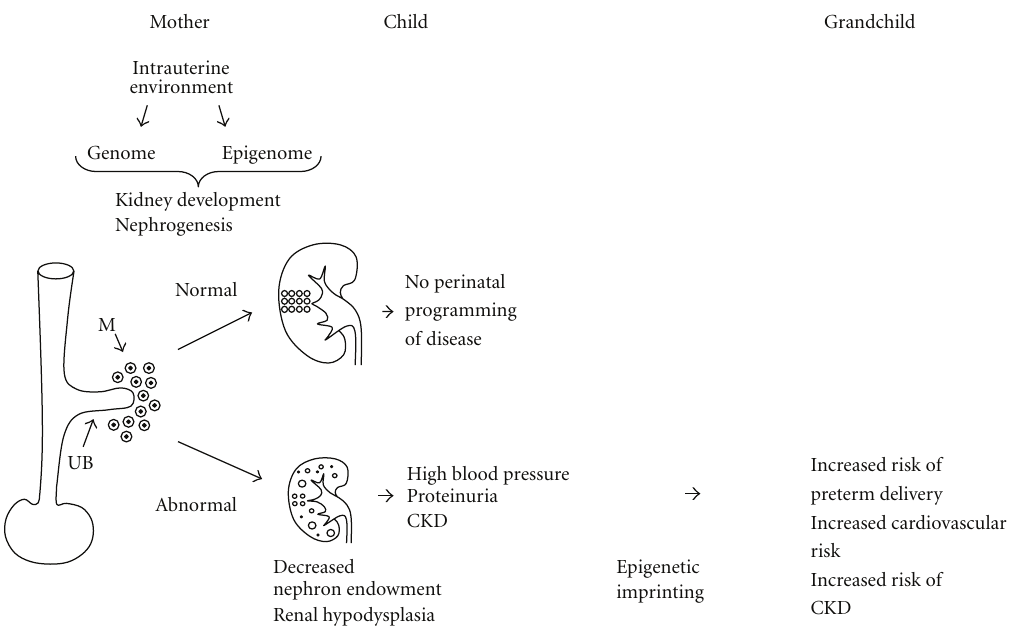
Figure 1: Schematic representation of the proposed impact of adverse intrauterine environment on developmental programming of hypertension and chronic kidney disease (CKD). Maternally mediated environmental modulation of renal gene expression in the o ff spring leads to developmentally induced deviations from the optimal nephron number. A relative deficiency in the number of nephrons is thought to create an increased risk of CKD, hypertension, and cardiovascular morbidity in later life. Epigenetic modifications not only change target gene expression and program the phenotype of the developing fetus, but also account for transgenerational inheritance of programmed phenotype via permanent epigenetic imprinting. UB: ureteric bud and M: metanephric